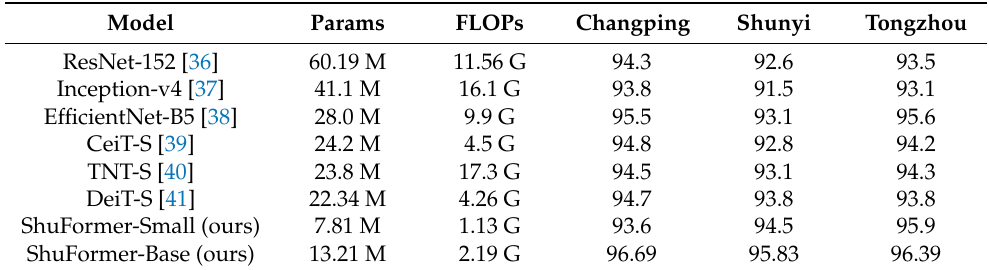
Table 4. Comparison of agricultural image classification models based on state-of-the-art CNN-based and transformer models.